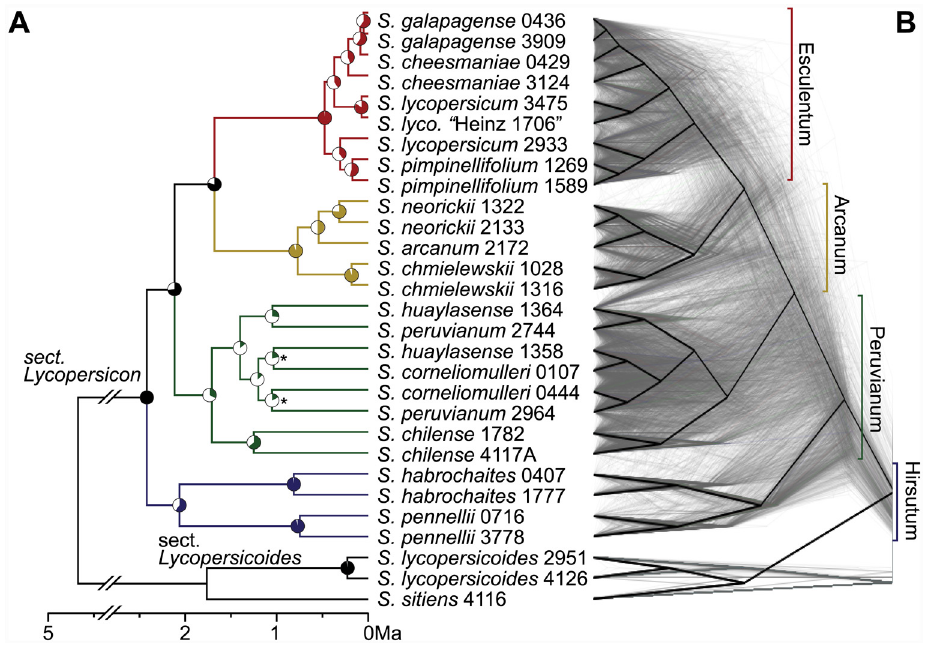
Fig 2. The phylogeny of Solanum sect. Lycopersicon . (A) A whole-transcriptome concatenated molecular clock phylogeny with section Lycopersicoides as the outgroup. Branch colors indicate the four major subgroups (labels on right). Pie charts on each node indicate majority rule extended bipartition support scores (out of 100) using trees from 100-kb genomic windows. All nodes are supported by 100 bootstrap replicates, except “ * ” denotes bootstrap support score of 68. (B) A “ cloudogram ” of 2,745 trees (grey) inferred from nonoverlapping 100-kb genomic windows (see also S2 Table). For contrast, the consensus phylogeny is shown in